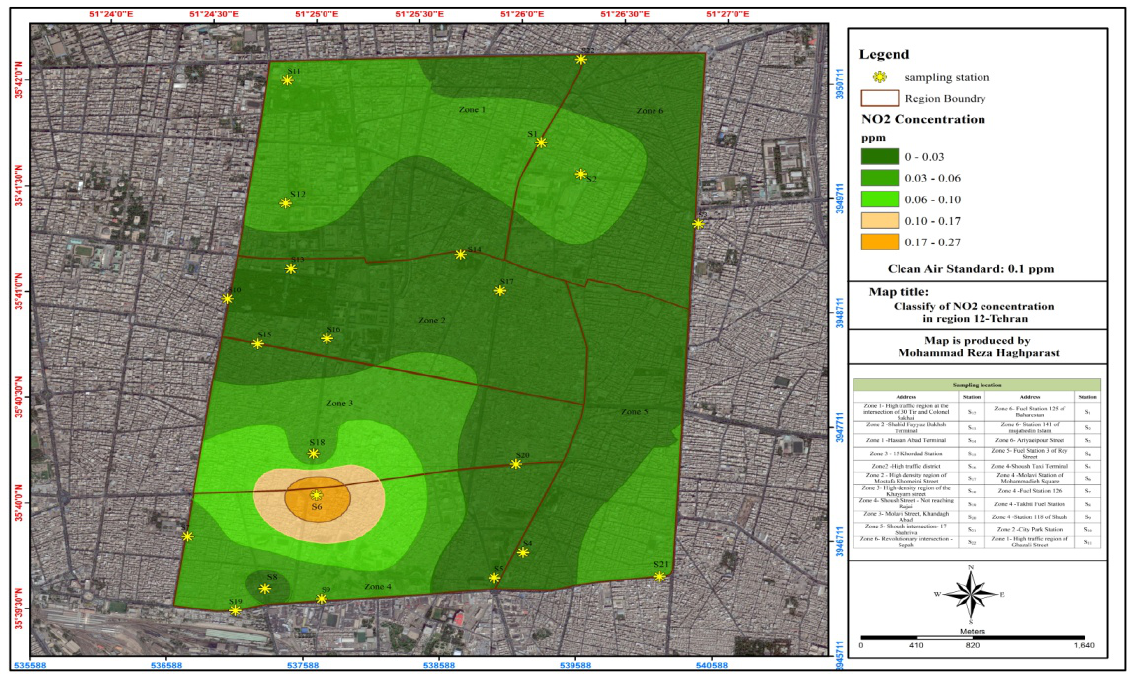
Figure 2. Zoning nitrogen dioxide concentration in the region on January, 2018